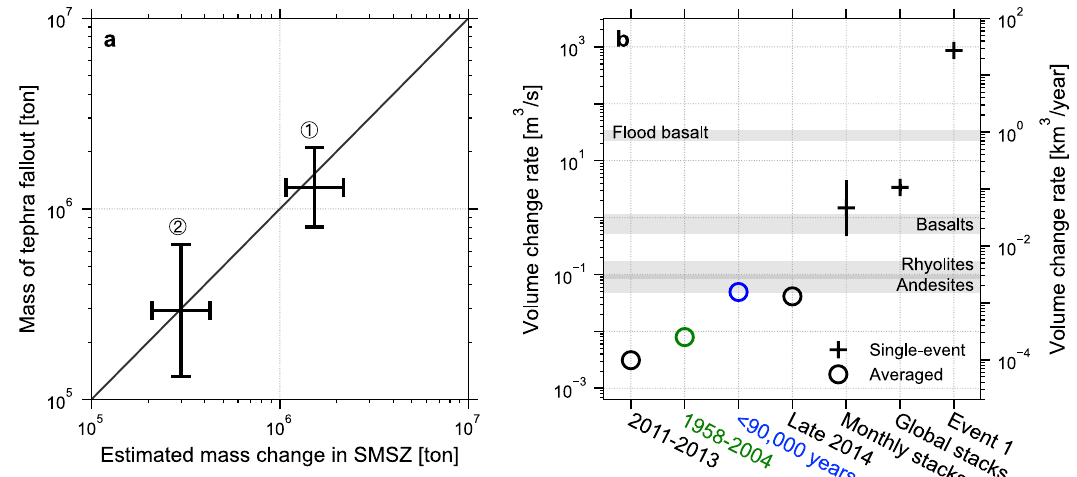
Fig. 6 Pre-eruptive mass change in the SMSZ versus retrospective tephra fallout mass and contrast of volume change rates across multiple time scales in Aso volcano. a The observed volcanic output of the 2014 Strombolian and 2016 phreatomagmatic eruptions against the estimated mass change inside the SMSZ before the eruptions. Enclosed 1 and 2 correspond to the time windows de fi ned in Fig. 5a. Horizontal bar shows the uncertainties of estimated mass change due to the magma compressibility (see text and Methods). Solid line shows the 1:1 reference line. b Comparing the single-event volume change rates (black cross) against the averaged volume change rates over 2011 – 2013 and late 2014 (black circles) (Fig. 5a), the geodetic data over 1958 – 2004 45 (green circle) and the geological analysis over post-caldera eruptions 23 (blue circle). Global averaged volcanic output rates from White et al. 80 are shown in the gray shaded